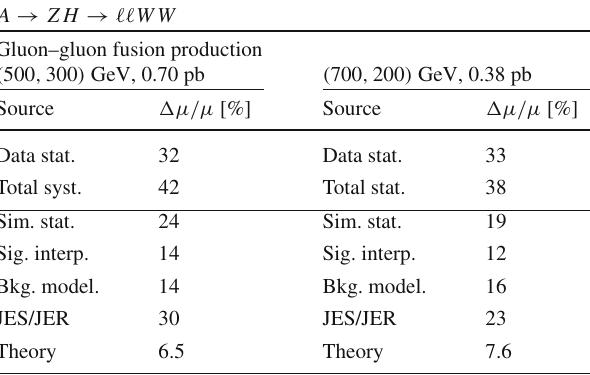
Table 4 The effect of the most important sources of uncertainty on the signal-strength parameter at two example mass points of ( m A , m H ) = ( 500 , 300 ) GeV and ( m , m ) = ( 700 , 200 ) GeV in the (cid:6)(cid:6) WW chan- A H nel for gluon–gluon fusion production of a narrow-width A boson. The same notation as in Table 3 is used A → Z H → (cid:6)(cid:6)